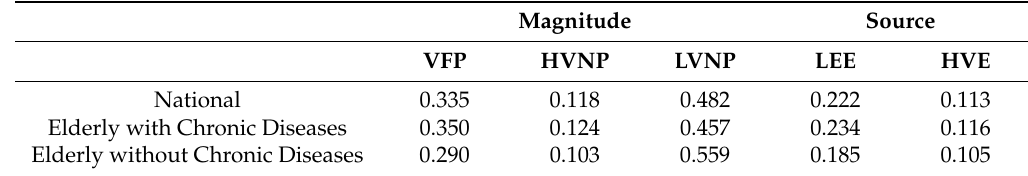
Table 3. Vulnerability